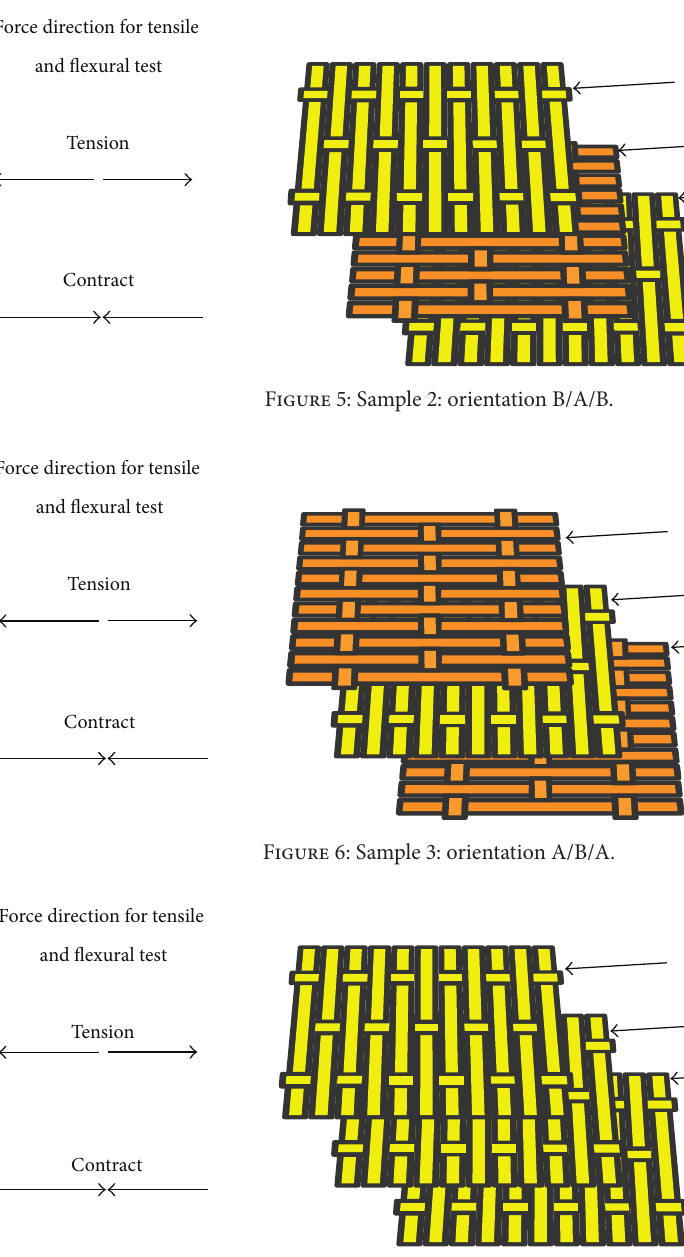
Figure 7: Sample 4: orientation